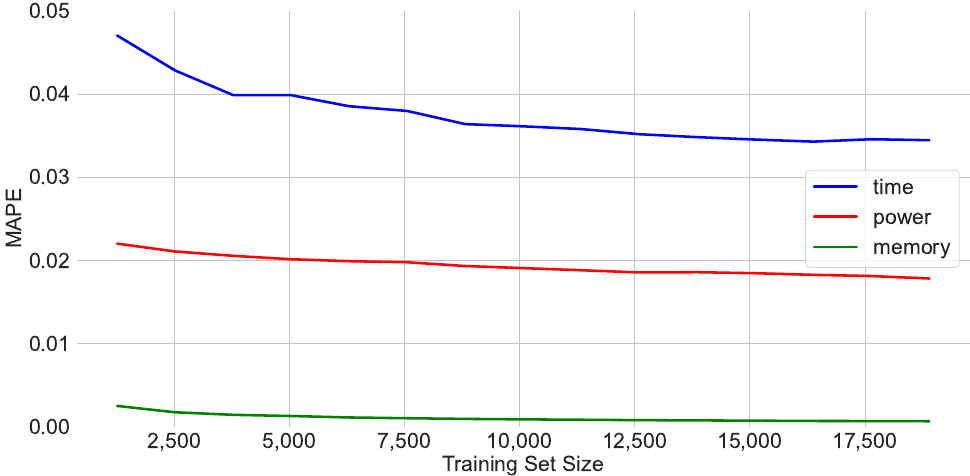
Figure 5. The development of the MAPE scores for the dense workload performance metrics on the GTX 980Ti with an increasing training set